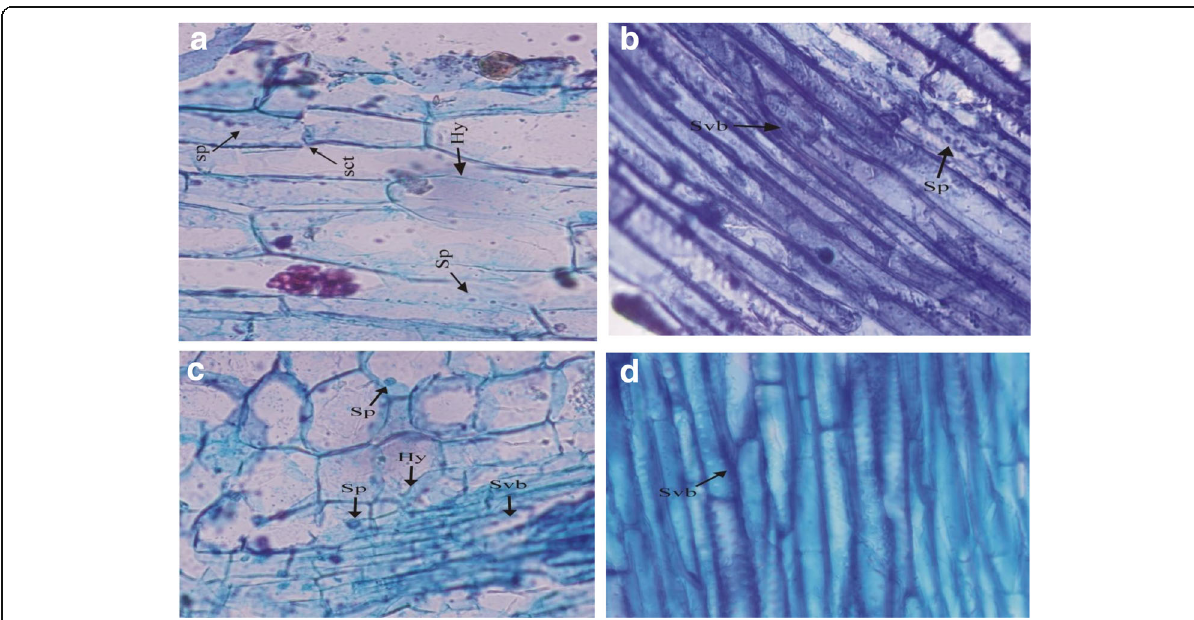
Fig. 6 a Histopathological interaction of T. harzianum and Phythium ultimum in cortex region of roots tissue of tomato plants (longitudinal section, 40 ×). b Histopathological interaction of T. harzianum and Phythium ultimum in vascular bundle of roots tissue of tomato plants (longitudinal section, 40 ×). c Histopathological interaction of Trichoderma harzianum and Phytopthora capsici in cortex region of roots tissue of tomato plants (longitudinal section, 40 ×). d Histopathological interaction of Trichoderma and Phytopthora capsici in vascular bundle of roots tissue of tomato plants (longitudinal section, 40 ×)